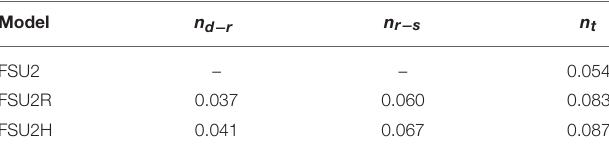
TABLE 3 | Calibration to single 3 -hypernuclei: for given R ω3 , values of R σ3 calibrated to reproduce the binding energies B 3 of hypernuclei in the s and p